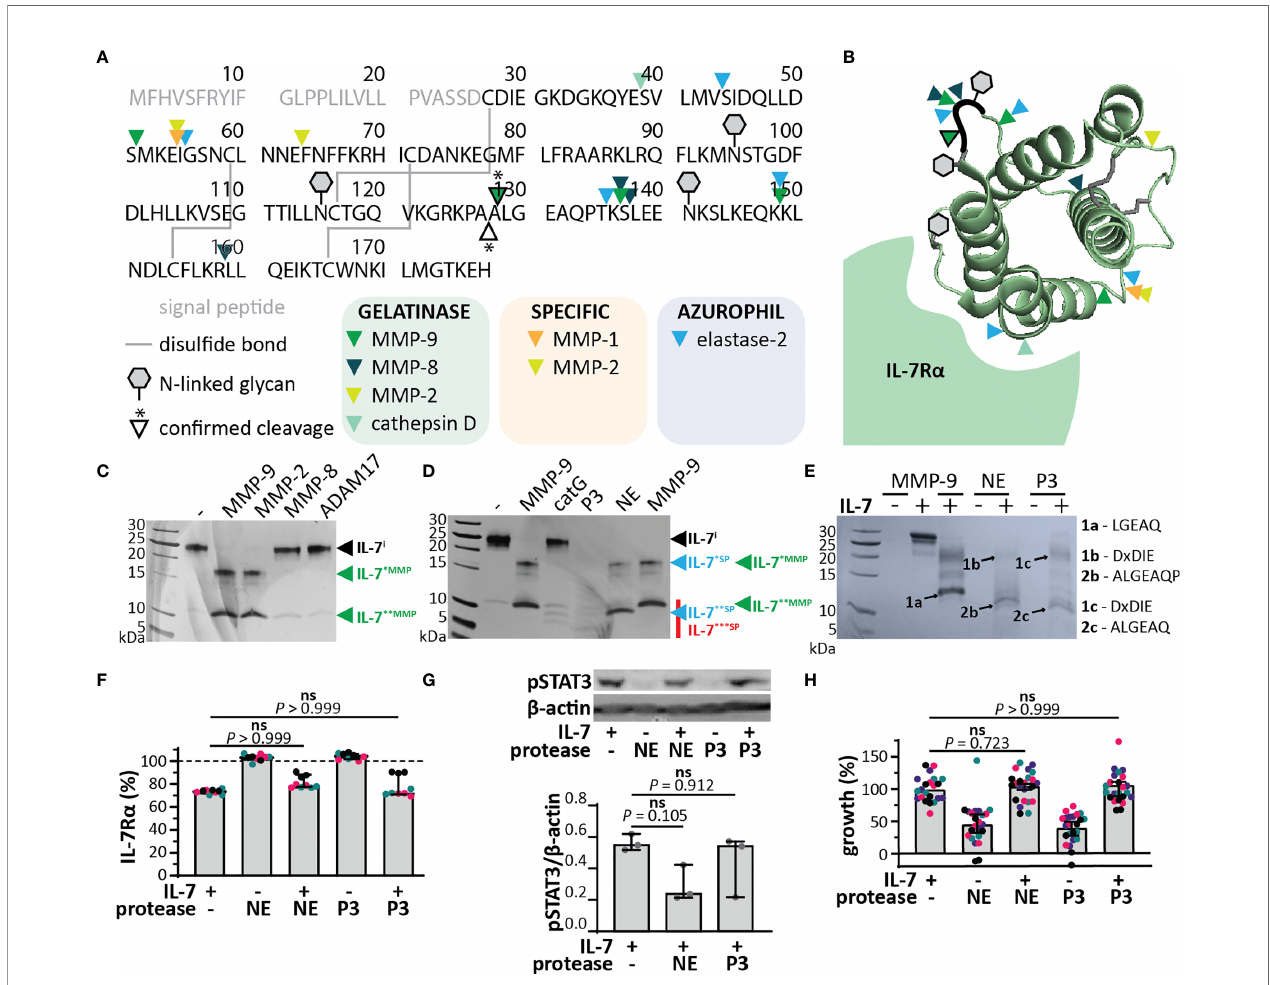
FIGURE 4 | IL-7 signaling through the IL-7 receptor remains intact upon cleavage by neutrophil proteases. (A) In silico prediction of IL-7 proteolysis by neutrophil proteases (iProt-Sub tool). Separation of proteases based on their place in neutrophil granules including gelatinase (green), speci fi c (orange) and azurophil granules (blue). (B) 3D model of IL-7 [PDB structure 3DI3 (29)] with indication of the location of the predicted cleavage sites for neutrophil proteases. (C) Digestion of IL-7 with a selection of metalloproteinases. Digestions at a molar ratio of 1/100 (MMP/IL-7) and for 4h. IL-7 i , intact IL-7; fragments are indicated by asterisks (*). (D) Digestion of IL-7 with the serine proteases catG, P3 and NE. Digestions at a molar ratio of 1/100 (protease/IL-7) and for 4h. (E) Edman sequencing data. Identi fi cation of the neo-N-termini generated upon digestion of IL-7 with NE or P3 (1:100, protease:IL-7 for 4h). Identi fi cation of the ALGEAQ N-terminus from fragment IL-7** SP , indicates a shared cleavage site between the amino acid residues A 127 and A 128 . (F) Analysis of cell-surface IL-7R, 5 minutes after stimulation of HPB-ALL cells with 50 ng/ml IL-7, cIL-7 (1/100 molar ratio MMP-9/IL-7, 4h at 37°C) or the equivalent of the indicated protease. Data represent three independent experiments, with all experimental replicates shown in the same color. Histograms represent median values and error bars represent the IQR. Data were normalized to the unstimulated condition, representing steady-state quantities of cell surface IL-7R (100% IL-7R a ). Statistical analysis done by Kruskal-Wallis test with Dunn ’ s correction for multiple comparisons and calculated on mean values of each experiment. (G) Analysis of pSTAT3 (Tyr 705 ) in HPB-ALL cells, 15 minutes after stimulation with 50 ng/ml IL-7, cIL-7 (1/100 molar ratio protease/IL-7, 4h at 37°C). Each data point indicates an independent experiment. Histograms represent median values and error bars represent the IQR. Data were normalized to b -actin. (H) Growth of HBP-ALL cells, 4 days upon stimulation with 50 ng/ml IL-7, cIL-7 (1/100 molar ratio protease/IL-7, 4h at 37°C) or the equivalent of MMP-9. Data represent four independent experiments, with all experimental replicates shown in the same color. Histograms represent medians and error bars represent the IQR. Data were normalized to cells stimulated with IL-7 alone, representing 100% growth. Statistical analysis done by Kruskal- Wallis test with Dunn ’ s correction for multiple comparisons and calculated on mean values of each experiment. ns, not signi fi